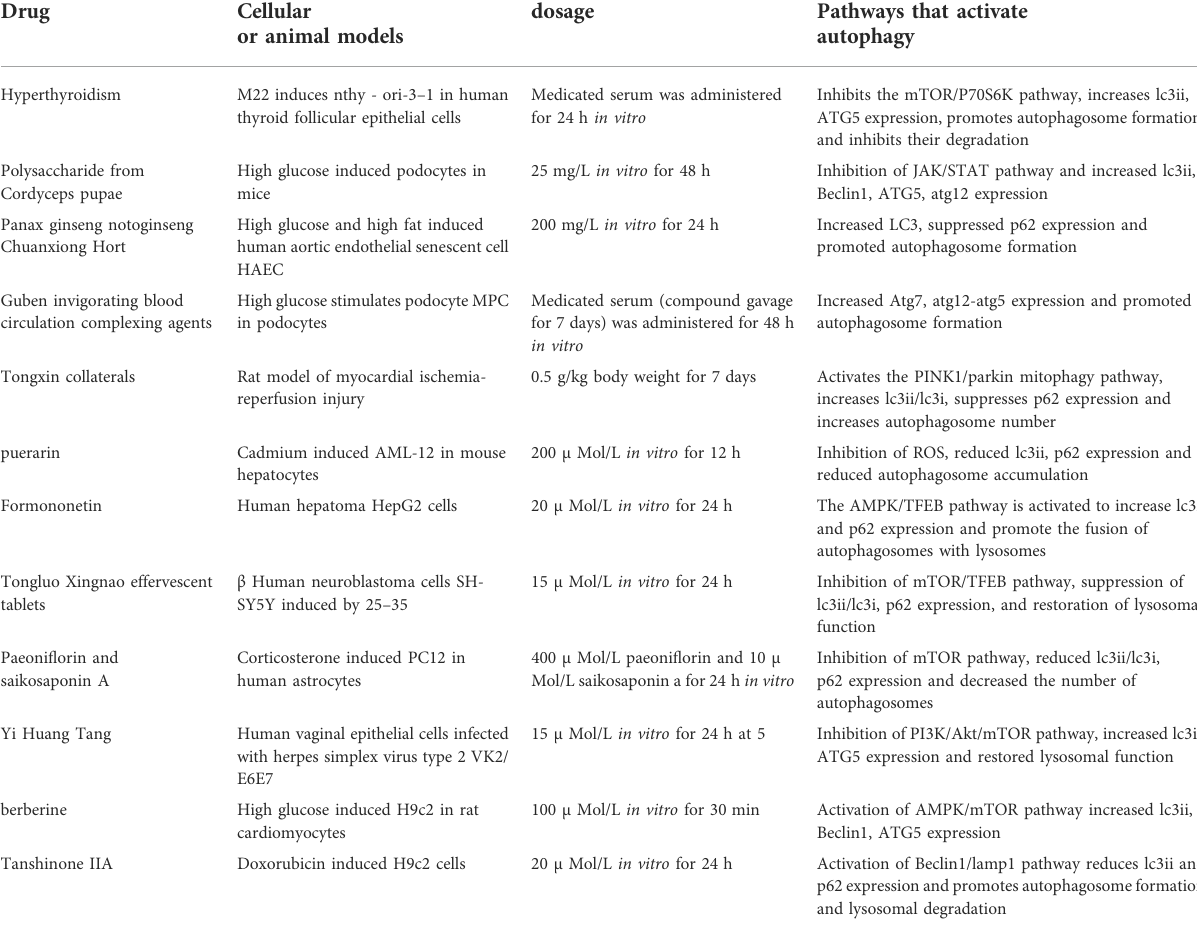
TABLE 1 Summary of drugs and mechanisms by which active ingredients and compounds of TCMs activate